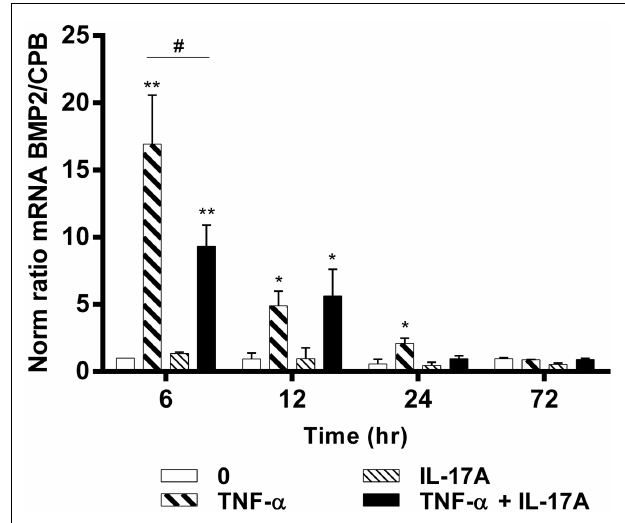
FIGURE 3 | Effects of IL-17A andTNF- α on BMP2 are shown . hMSCs were cultured in osteogenic medium in the presence or absence ofTNF- α 1ng/ml and/or IL-17A 50ng/ml. Osteogenic gene expression of BMP2 was measured by qRT-PCR at early time points of (6, 12, 24, and 72h). Results were analyzed using theWilcoxon test. * p < 0.05; ** p < 0.005 vs. induction medium alone (0), # p < 0.05TNF- α alone vs. IL-17A + TNF- α .